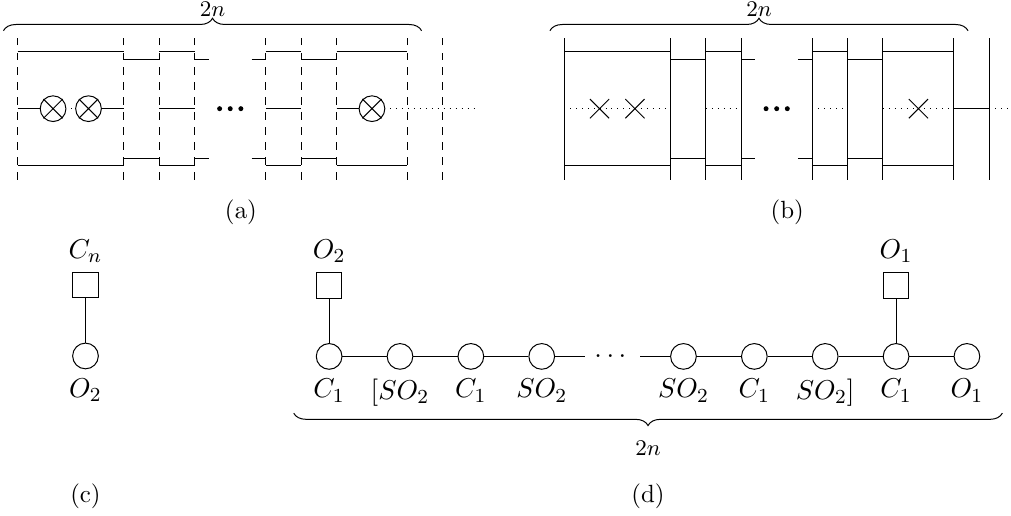
Figure 59. ~ c n := (cid:22) O singularity. (a) Brane subsystem that represents the moduli space (2 2 ; 1 2 n (cid:0) 4 ) generated by 2 n (cid:0) 1 D3-branes. There are a total of 2 n + 1 half D5-branes in the system. (b) After S-duality the moduli space generated by these D3-branes as a Coulomb branch. (c) Quiver corresponding to brane system (a), its Higgs branch is M H = (cid:22) O (see for example [47]). (d) (2 2 ; 1 2 n (cid:0) 4 ) Quiver corresponding to brane system (b), its Coulomb branch is predicted to be M C = (cid:22) O . (2 2 ; 1 2 n (cid:0) 4 )